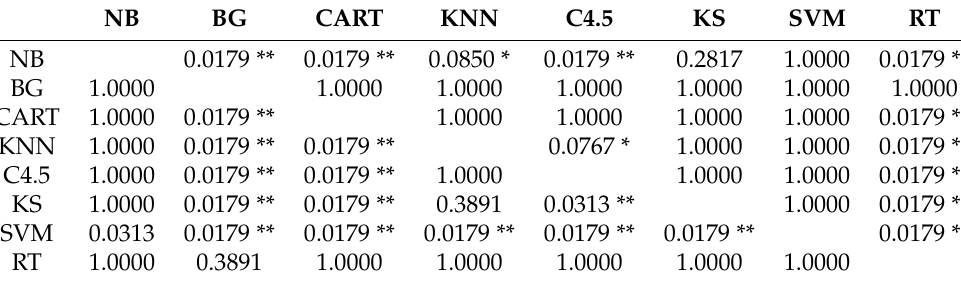
Table 22. Pairwise WSR test for kappa statistics of adults.